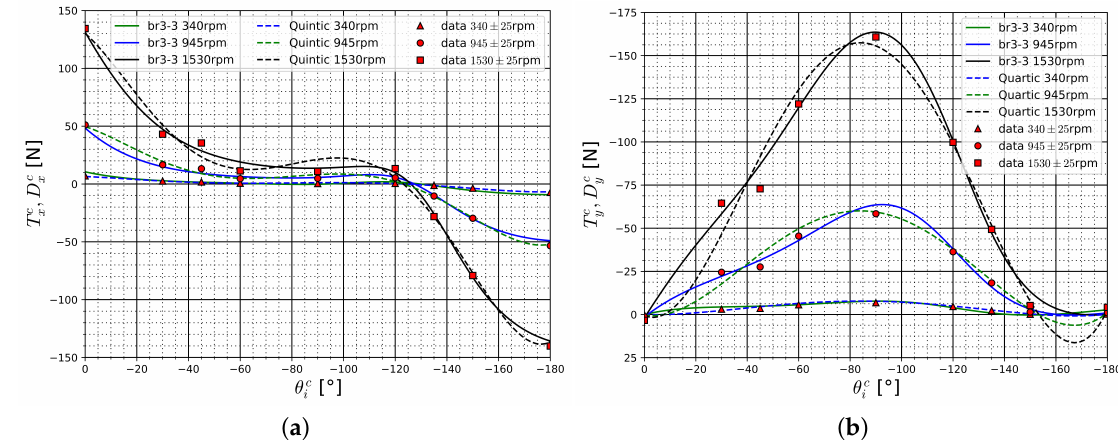
Figure 14. Comparison neural network and propeller-characteristics-based model fits for ( a ) T c x and